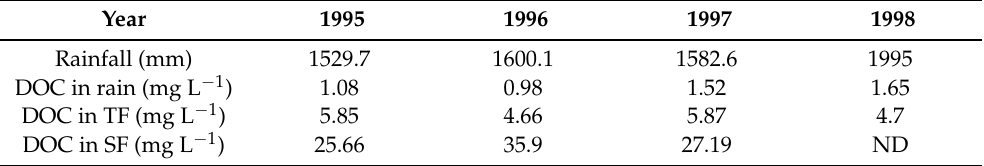
Table 2. Annual rainfall amount and weight-average DOC concentration of the rain, throughfall, and stemflow in a 35-year-old sugi forest (35 ◦ 0 (cid:48) 23 (cid:48)(cid:48) N, 135 ◦ 48 (cid:48) 59 (cid:48)(cid:48) N) in Kyoto Prefecture, Japan. Year 1995 1996 1997 1998 Rainfall (mm) 1529.7 1600.1 1582.6 1995 1.08 0.98 1.52